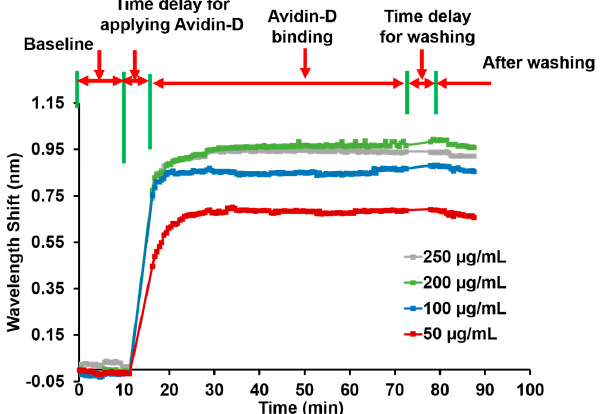
Figure 3. Wavelength shift and process steps as a function of time for 50, 100, 200, and 250 µ g / mL Avidin-D concentrations. The final wavelength shifts are approx. 0.67, 0.86, 1.03, and 0.92 nm for 50, 100, 200, and 250 µ g / mL Avidin-D,